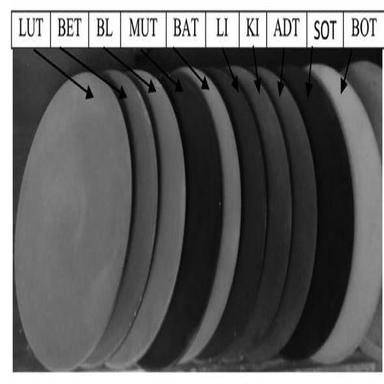
Equivalent materials LUT, BET, BL, MUT, BAT, LI KI, ADT, SOT and BOT, identified by different colors using organic dyes.